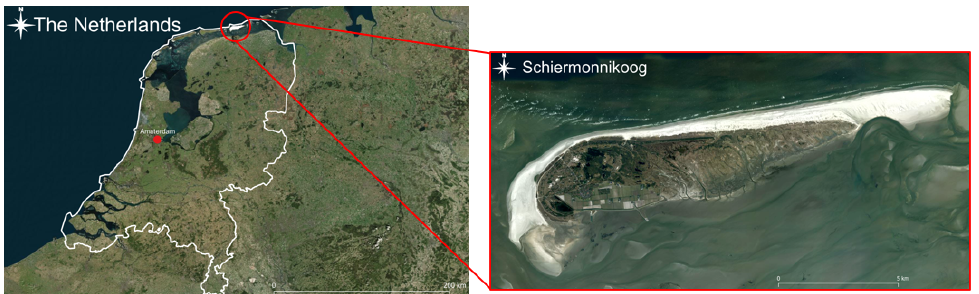
Figure 1. Location of Schiermonnikoog national park .